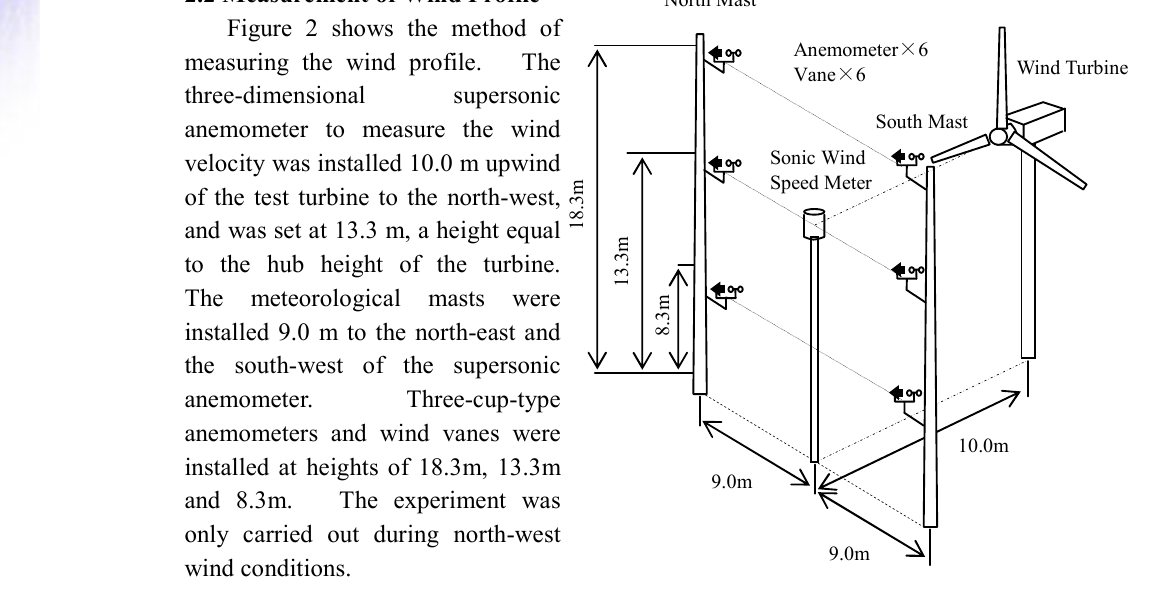
Fig.2 Schematic view of the wind speed measurements upwind the